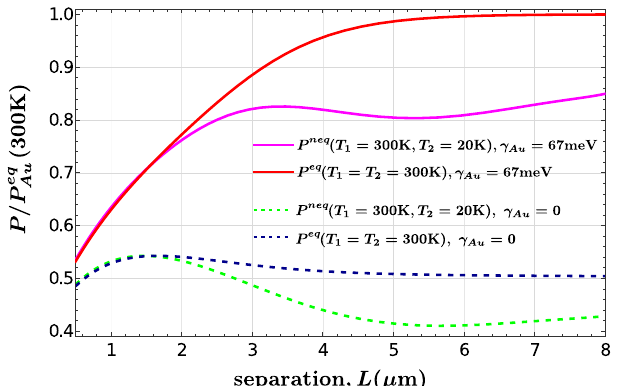
Figure 1. Casimir pressure between two semi-infinite YBCO plates in ( P eq ) and out ( P neq ) of thermal equilibrium as a function of the plates separation, L . The pressure axis is normalized to the equilibrium pressure between two gold plates at 300 K. When the gold permittivity is described using the Drude model with a finite damping rate γ Au = 67 meV, the normalization conduces to the pressure curves given by the solid lines. If the damping rate is neglected in the normalization γ Au = 0 , the dashed lines are